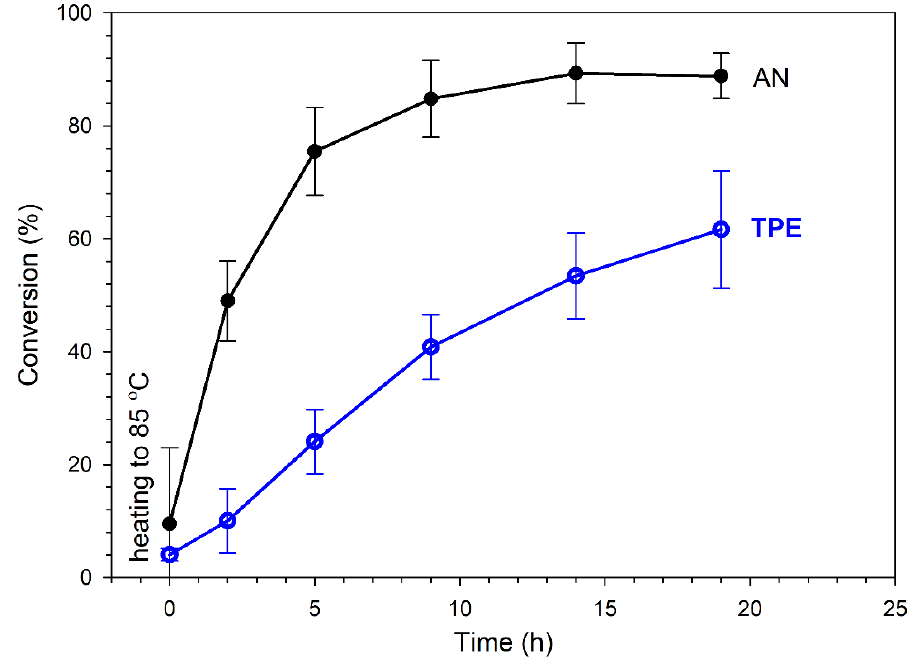
Figure 6. Conversion of AN and TPE groups decomposition as a function of heating time (reaction in an NMR tube in DMSO-d 6 ); plots based on average values of three measurements.